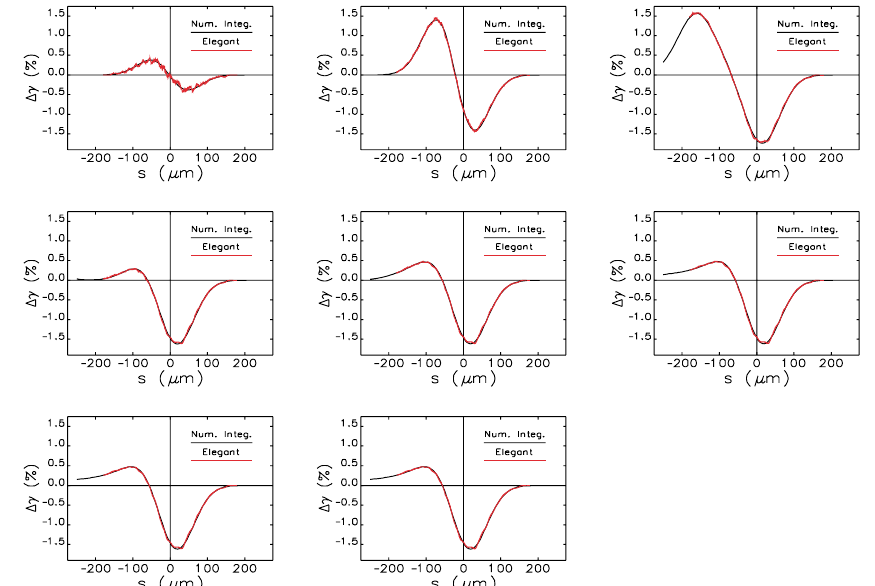
FIG. 1. (Color) Comparison of ELEGANT simulation and numerical integration, showing the change in g in successive pieces of a dipole. Successive frames are separated by an angle of 20 mrad.